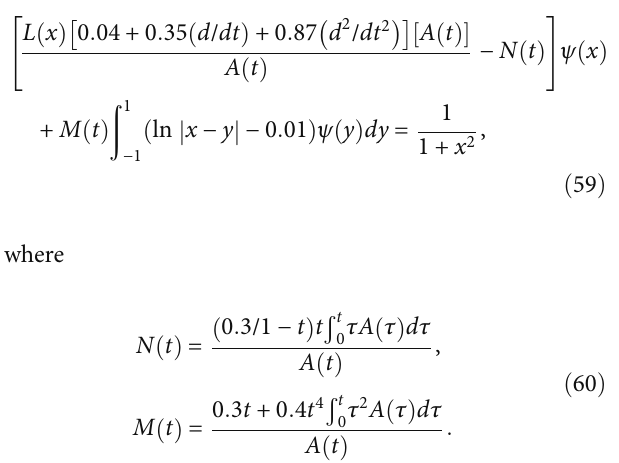
, where g ð x Þ = C